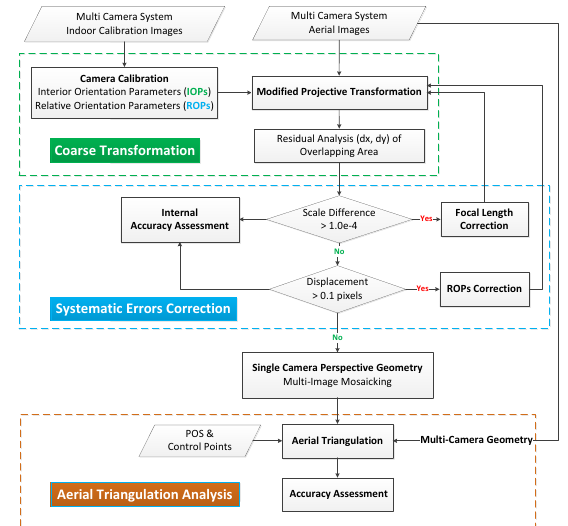
Figure 6. Image Mosaicking and Accuracy Analysis Workflow